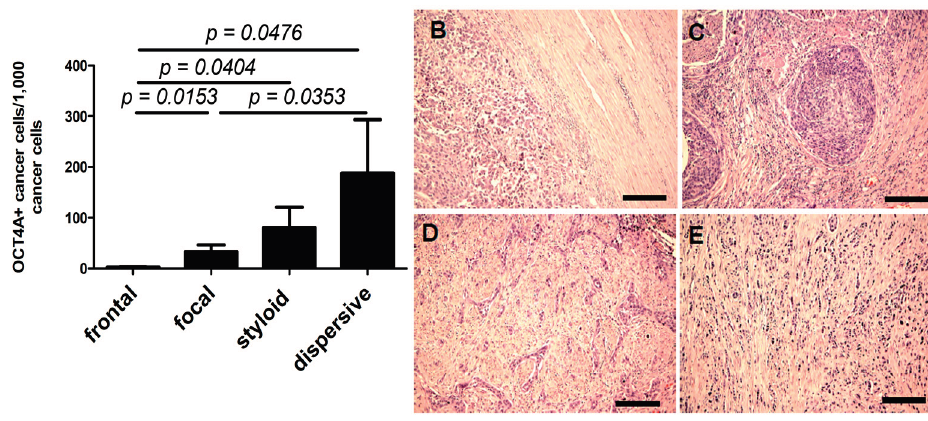
Figure 5. The percentage of low-intensity OCT4A-positive cells ( A ) was higher in tumors with higher aggressiveness of local invasion, styloid ( D ) and dispersive ( E ), compared with tumors with lower aggressiveness of local invasion, frontal ( B ) and focal ( C ). Scale bars: 100 µm. Significant differences are denoted by p -values ( t -test).